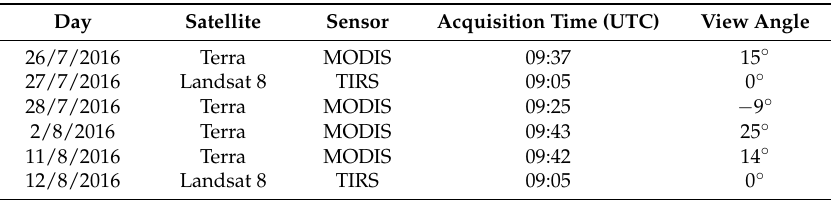
Table 2. Selected dates and characteristics of the LST